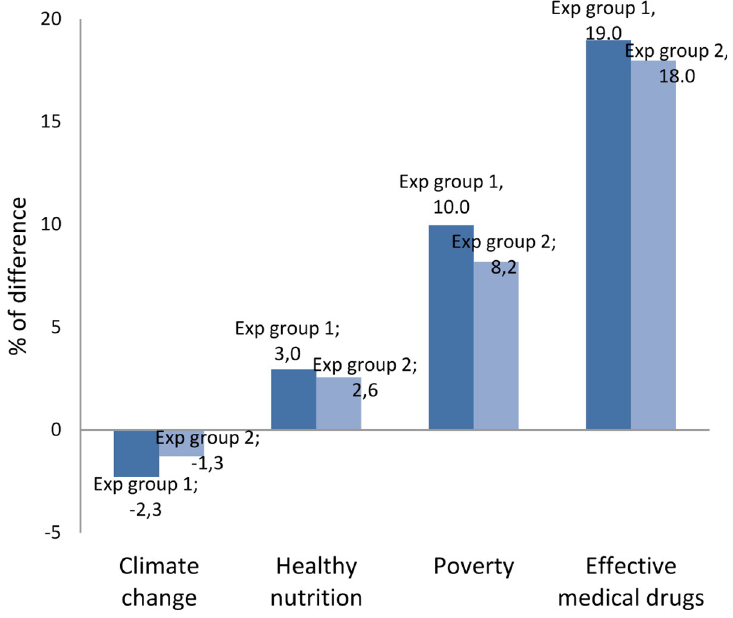
Fig 1. Share of difference in people’s perception–before and after actually testing them–for being able to explain climate change, healthy nutrition, poverty, and medical drug effectiveness.